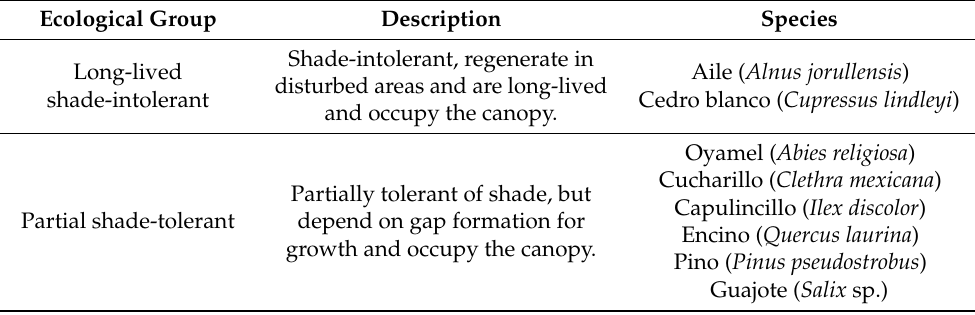
Table 5. Natural regeneration of tree species (Ejido Palo Seco, Coatepec Harinas, M é xico) in a har- vested forest. Small Species Seedlings Saplings Seedlings